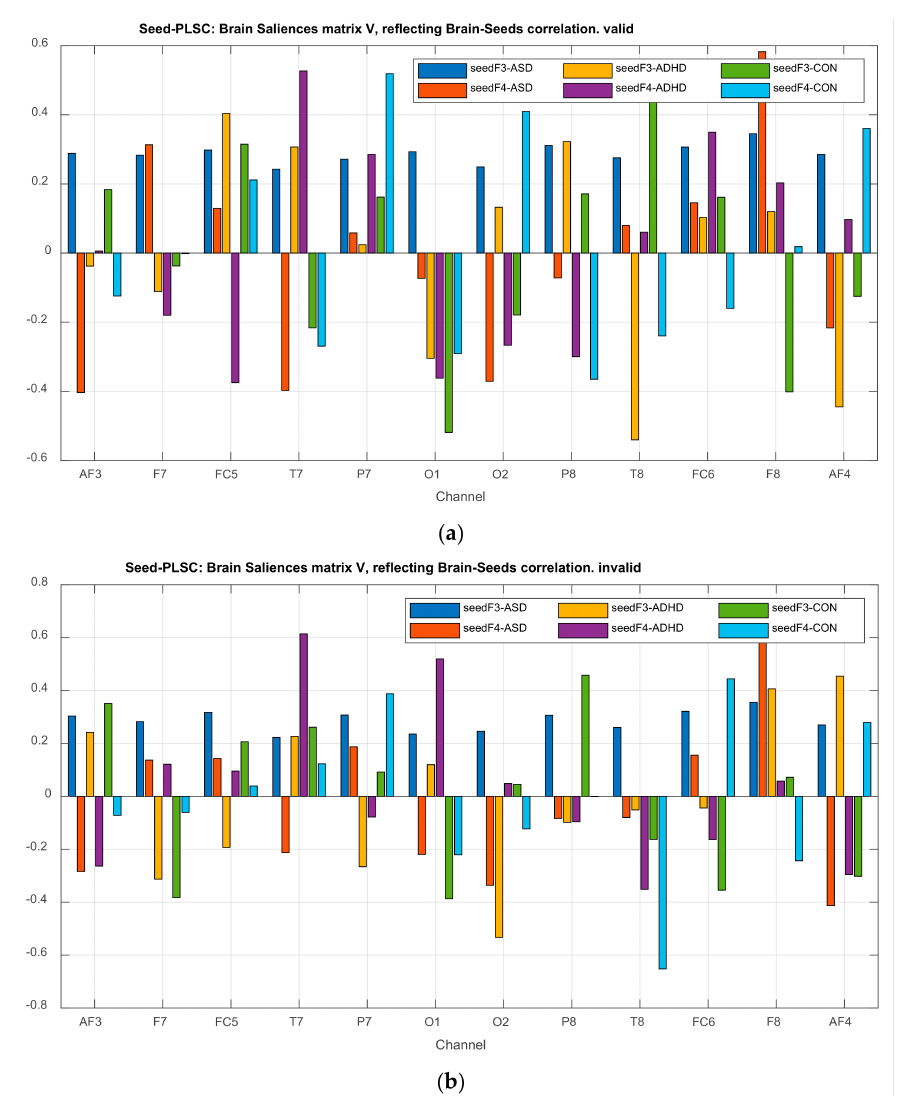
Figure 30. ( a ) Brain saliences matrix V reflecting the activated regions of the brain due to seed regions F3 and F4 activations , for the valid syllogism. ( b ) Brain saliences matrix V reflecting the activated regions of the brain due to seed regions F3 and F4 activations , for the invalid